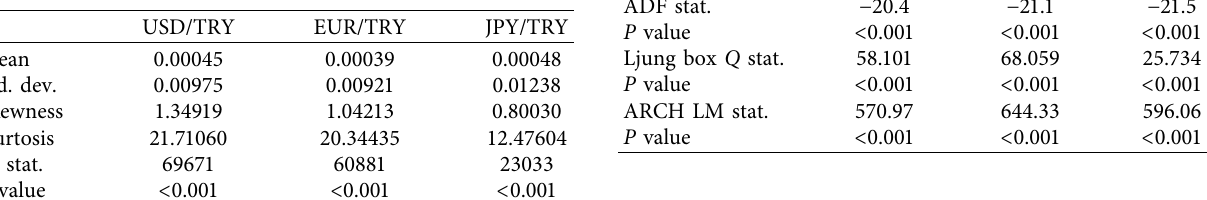
Figure 1: Return series of the exchange rates. Table 2: Statistical tests for the exchange rate Table 1: Descriptive statistics of the exchange rate returns.